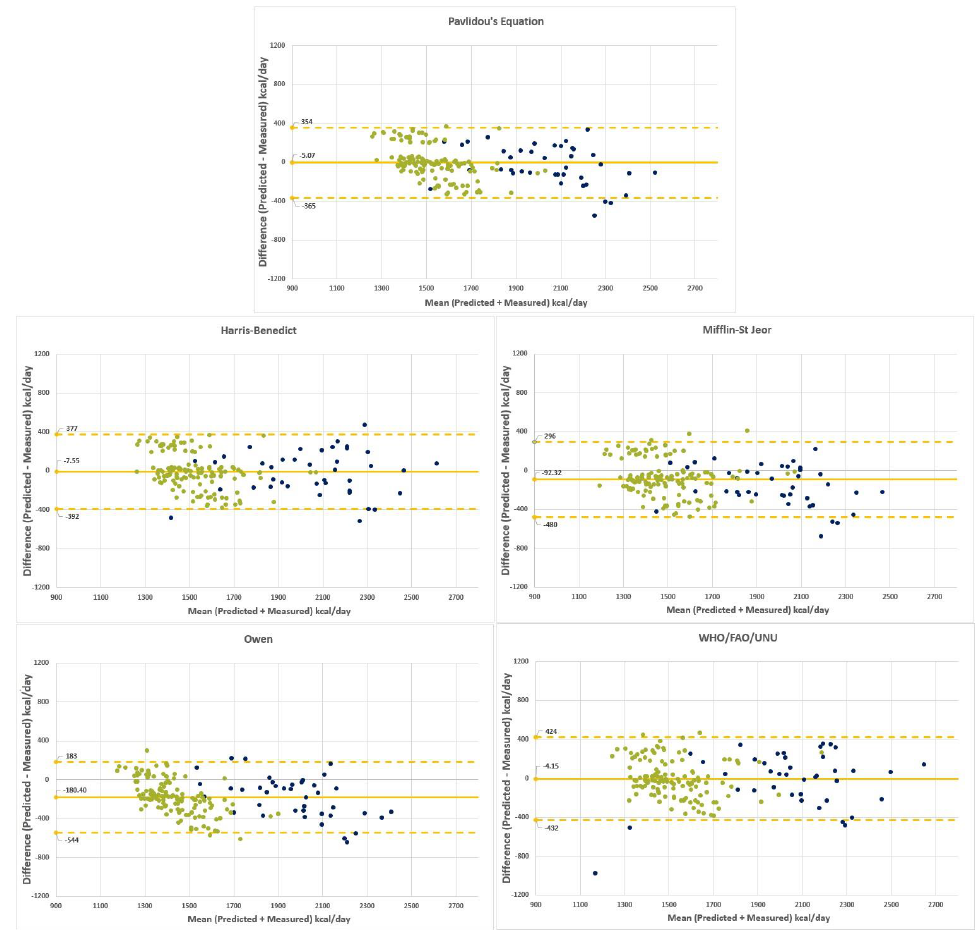
Figure 2. Bland–Altman plots. Bland–Altman plots display the mean of the differences between predicted and measured resting metabolic rates using the selected equations for men and women with a solid line. The dotted lines represent 1.96 SDs from the mean (limits of agreement). Note that the green dots are for females and the blue ones for males.